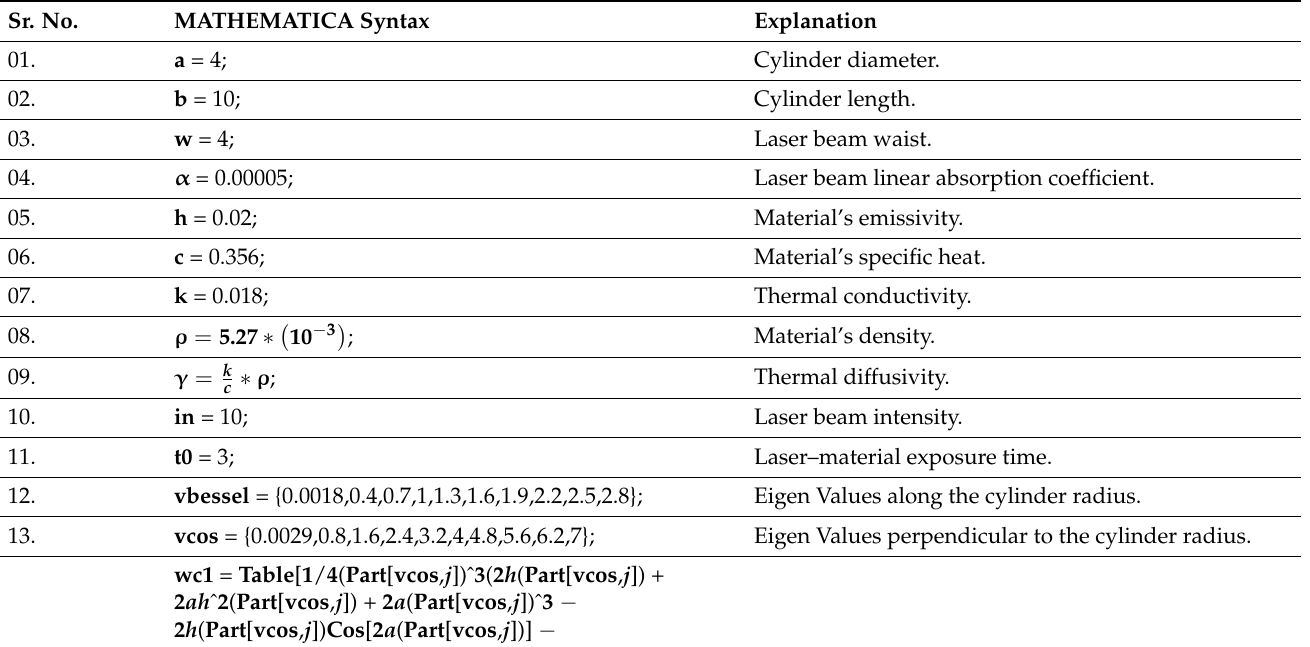
Table A1. Fourier heat equation with “MATHEMATICA” software user-defined codes with an